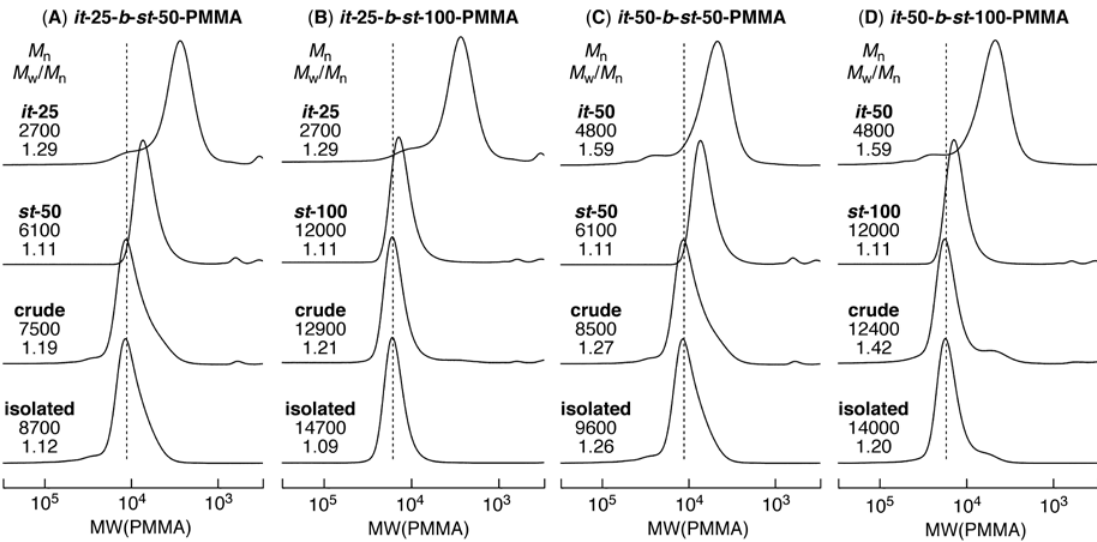
Figure 5. SEC curves of a series of it -PMMA-N 3 , st -PMMA-C≡CH, and it - b - st -stereoblock PMMAs obtained via CuAAC in the presence of CuSO 4 /sodium ascorbate in DMSO/H 2 O (98/2) at 70 °C ([–N 3 ] 0 /[–C≡CH] 0 /[CuSO 4 ] 0 /[sodium ascorbate] 0 = 15/15/5/20 mM) as prepared and after reprecipitations. ( A ) it -25- b - st -50; ( B ) it -25- b - st -100; ( C ) it -50- b - st -50; ( D ) it -50- b - st -100. In the 1 H NMR spectrum of the obtained polymers, new peaks for the triazole-ring methine ( j ) at 7.8 ppm and the adjacent methylene ( g 4 ) protons at 5.2 ppm appeared due to the reaction of the alkyne group at the α-end of st -PMMA with the azide ω-terminal of it -PMMA (Figure 6C). Although